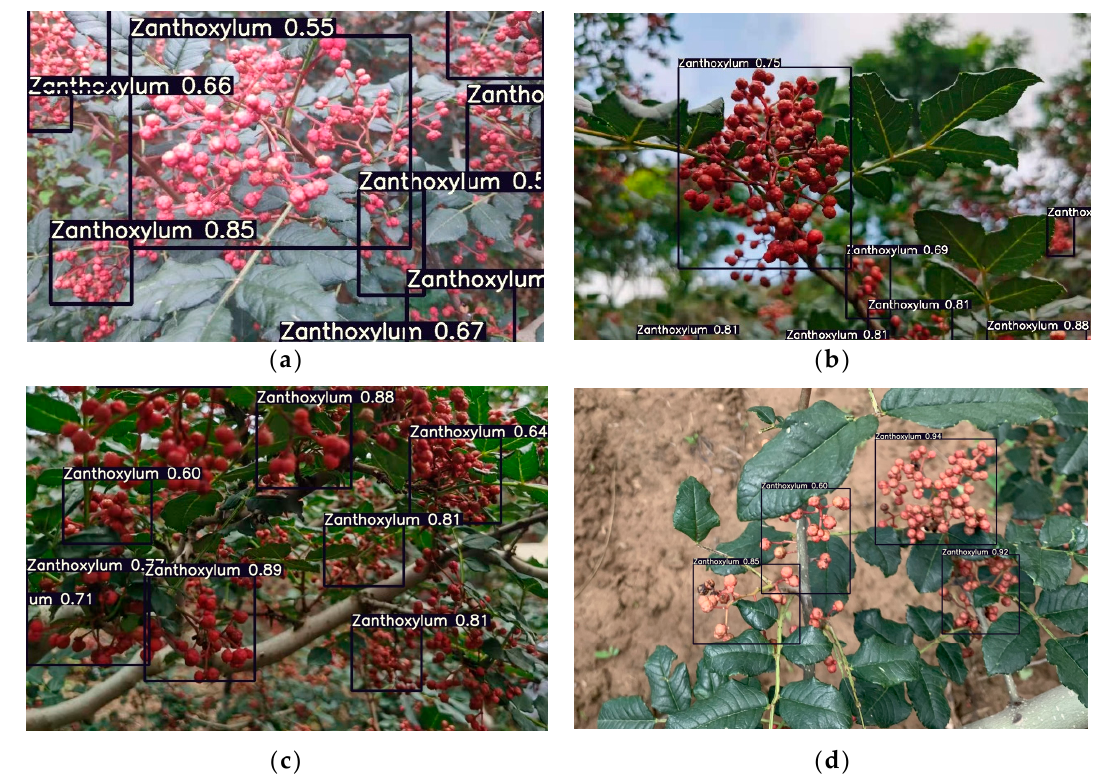
Figure 13. Recognition results of Zanthoxylum by the improved YOLOv5s network under different illumination environment on TX2 platform. ( a ) Multiple clusters of blocked Zanthoxylum fruit. ( b ) Single cluster of Zanthoxylum fruit under backlight. ( c ) Multiple clusters of blocked Zanthoxylum fruit. ( d ) Single cluster of Zanthoxylum fruit under backlight.